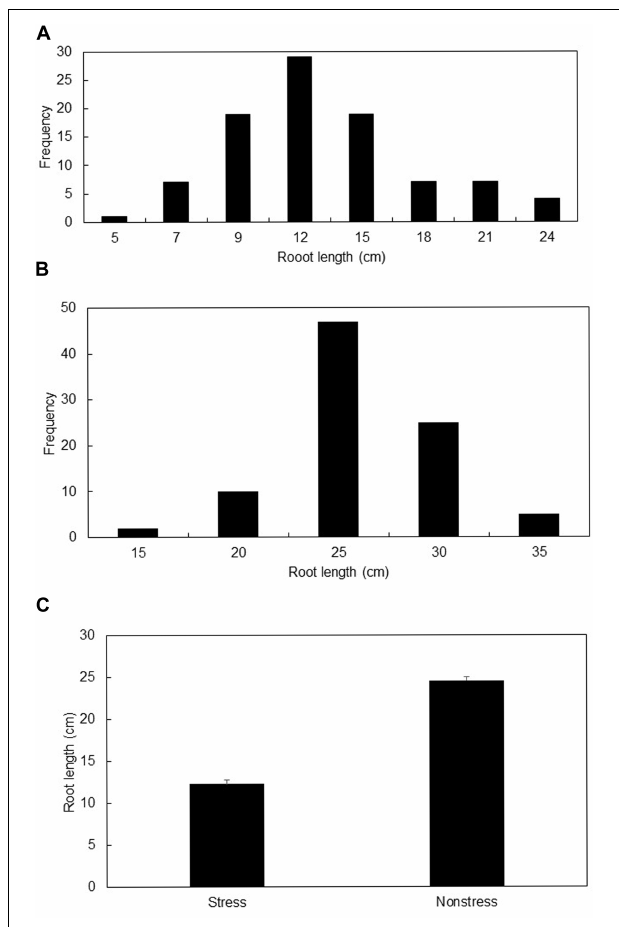
FIGURE 1 | Distribution of mean root length (cm) under stress (A) , and non-stress (B) growing conditions, and the mean root length (cm) ± SE of all genotypes under stress and non-stress conditions (C) .